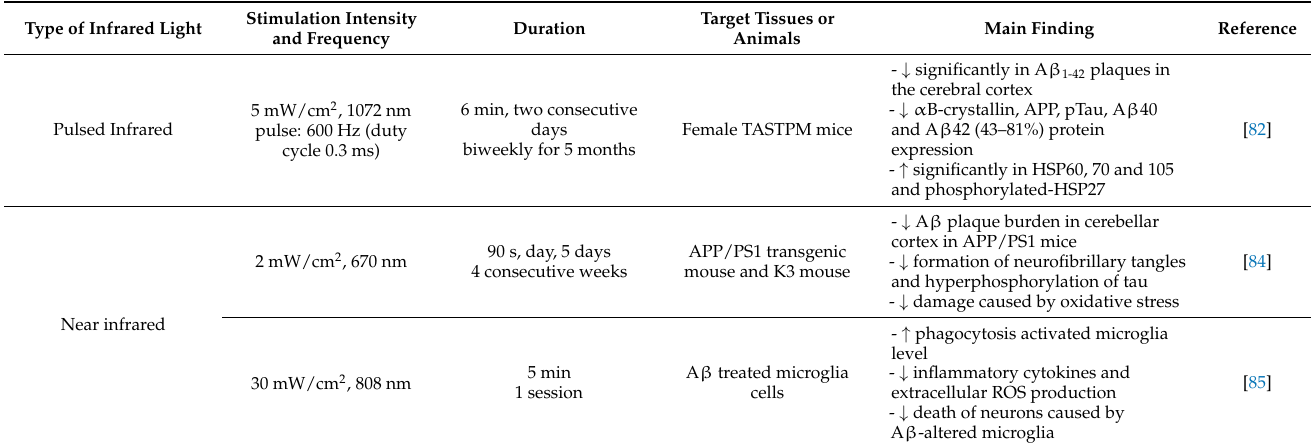
Table 4. A summary of infrared light stimulation on A β and tau